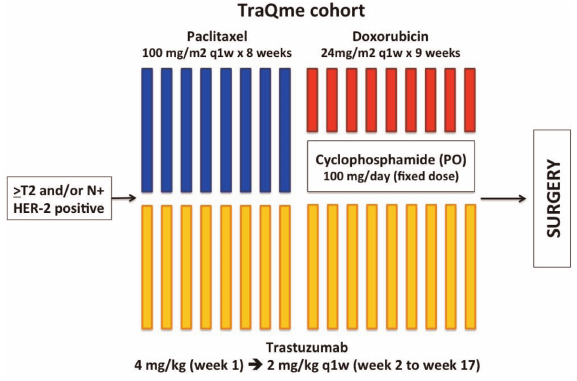
Figure 1. TraQme cohort study